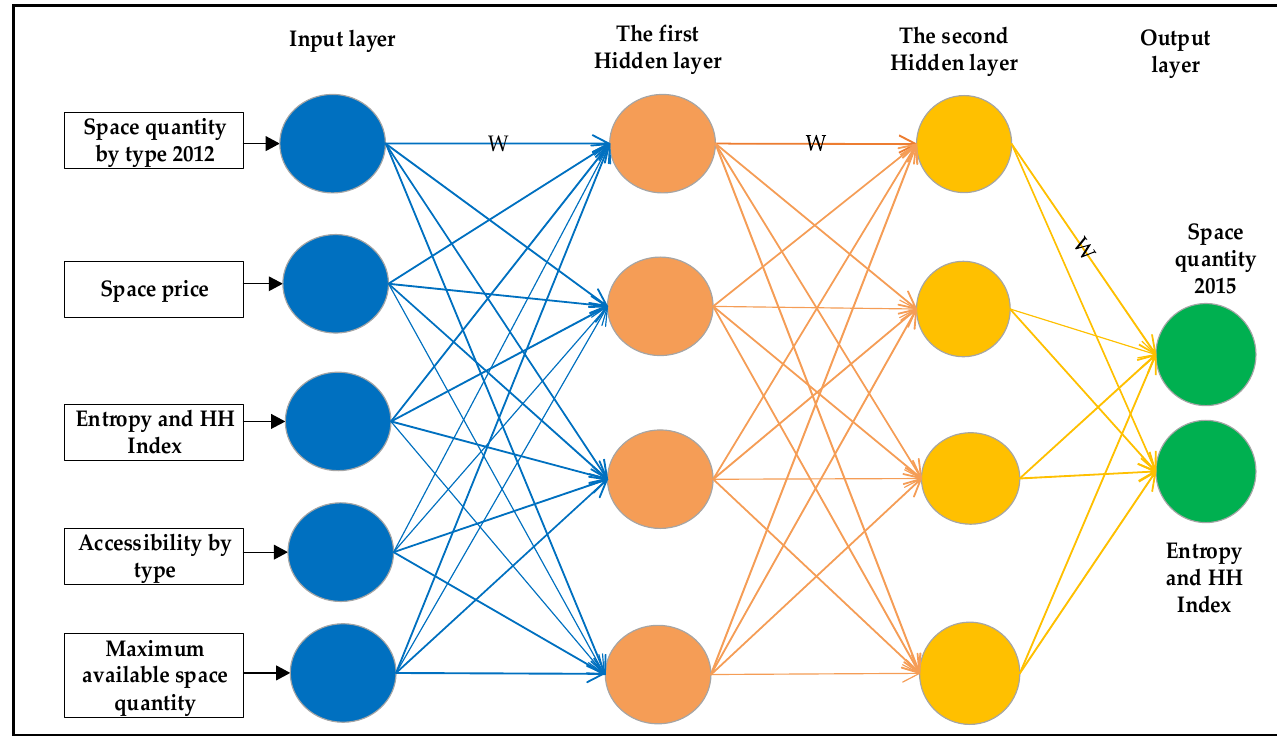
Figure 7. MLP neural network structure.